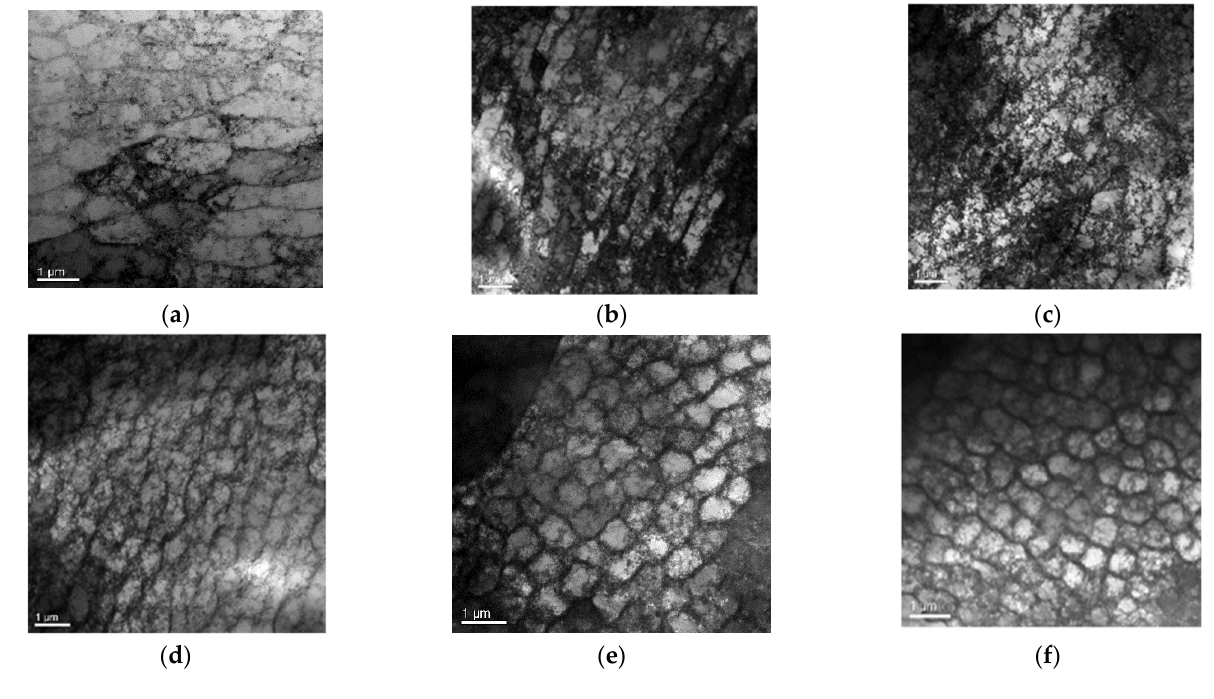
Figure 11. The TEM photographs of the SLM 316L stainless steel specimens subjected to different fatigue cycles. ( a ) Specimen C1 (10,000 times). ( b ) Specimen C2 (20,000 times). ( c ) Specimen C3 (30,000 times). ( d ) Specimen C4 (40,000 times). ( e ) Specimen C5 (50,000 times). ( f ) Specimen C6 (68,920